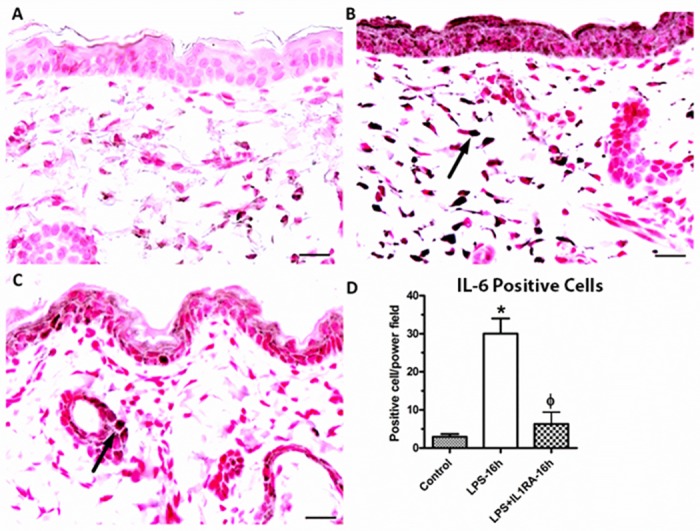
IL-6 expression.Representative photomicrographs for IL-6 (1:400) immunohistochemical staining of fetal skin. (A) control; (B) LPS at 16 h; (C) LPS and IL-1ra at 16 h exposure. (D) The number of positive cells (arrow), that were counted between groups. (magnification bar represents 20 μm). *indicates a significant increase in the number of positive cells relative to the untreated control. ɸ indicates a significant decrease in number of positive cells relative to LPS.